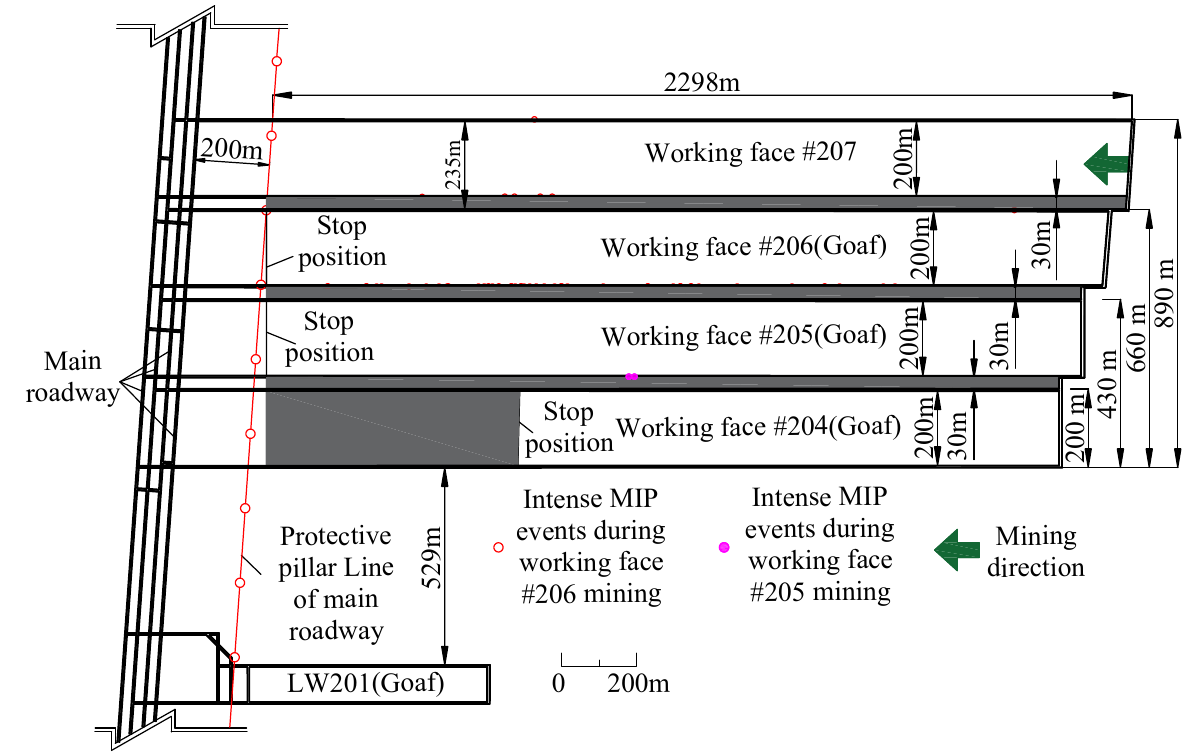
Figure 2. The layout of working faces and mining conditions in Panel #2. Working Face #207 was immediately mined after Working Face #206 had been fully extracted, with its working face having a face width of 200 m, advancement length of 2298 m, design extraction height of 6–9 m (7.5 m on average), and coal seam dip angles of 0–8 ◦ . Coal pillars at 30 m intervals were left in the goaf between Working Faces #207 and